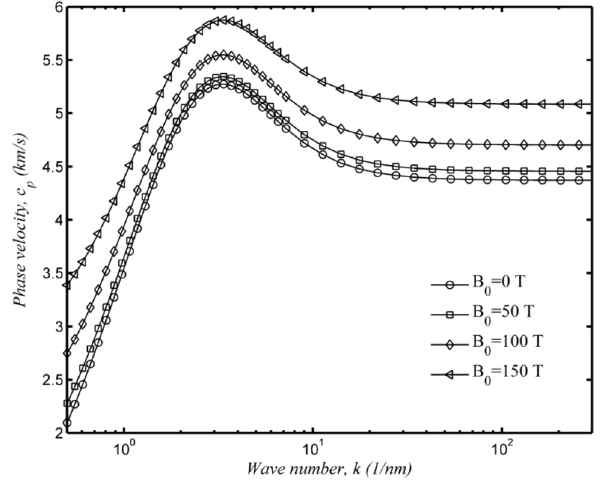
Fig. 4 The phase velocity against the wave number with = 1000 m ∕ s , Kn = 0 .001, l v avg ( slip ) various intensity of magnetic field